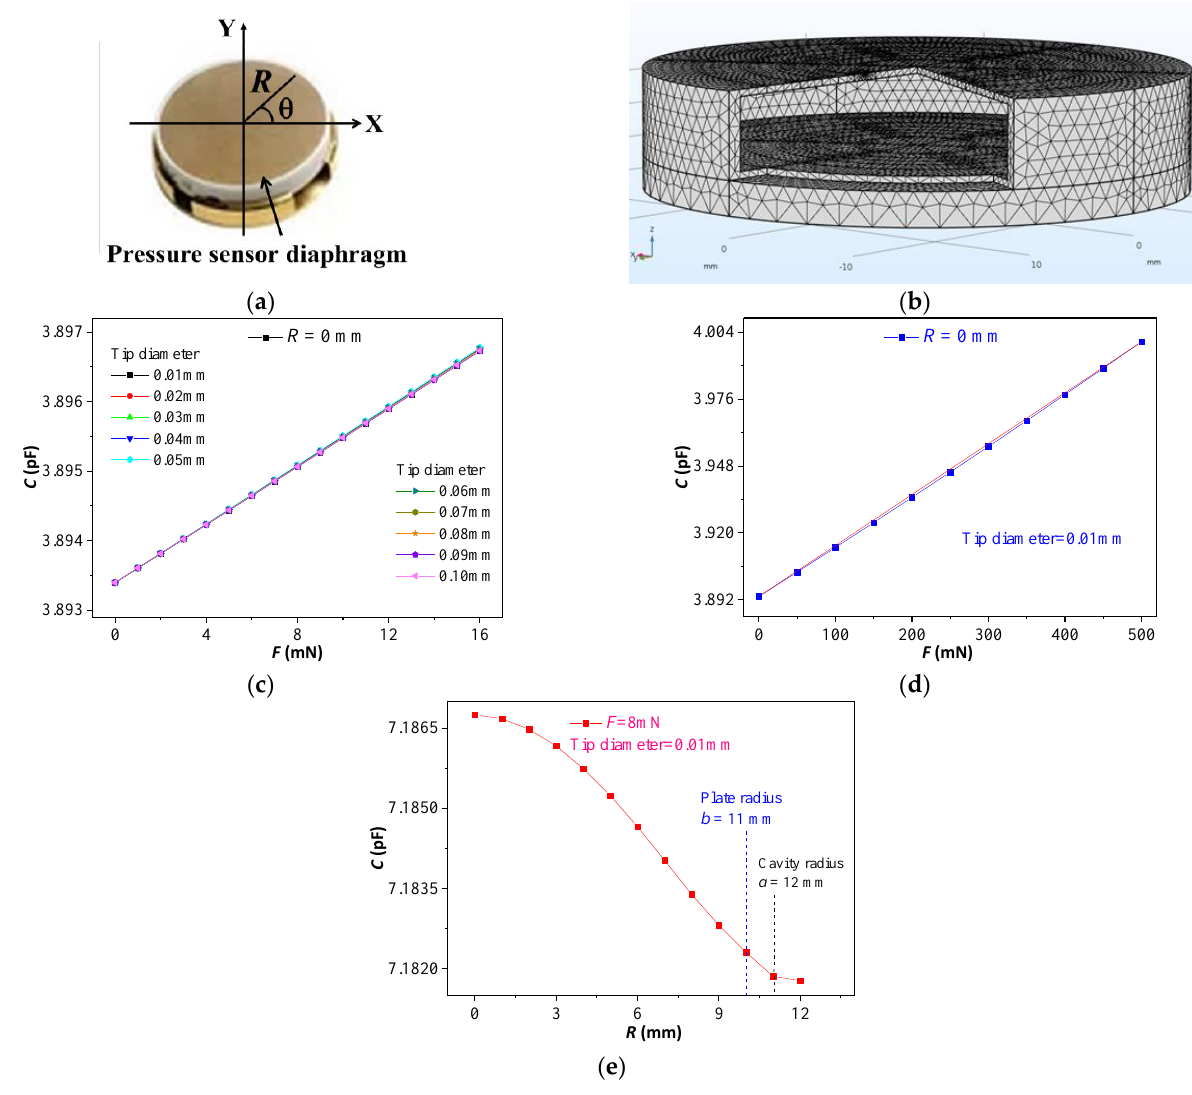
Figure 4. ( a ) Photo of the microcapacitive pressure sensor. ( b ) 3D geometry model of the pressure sensor. ( c , d ) Relation between the contact force of two different intervals and the capacitance of the pressure sensor with the plate radius b = 11 mm. ( e ) Relation between the radius of the contact force’s action point and the